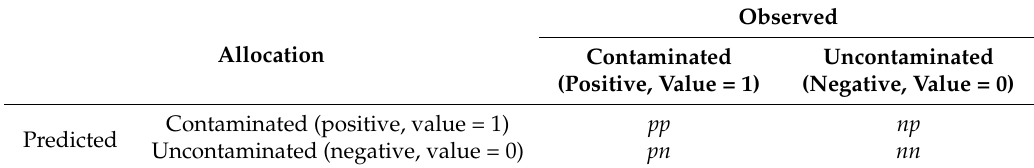
Table 1. Confusion matrix of observed and diagnosed soil samples for calculating overall accuracy 1 .